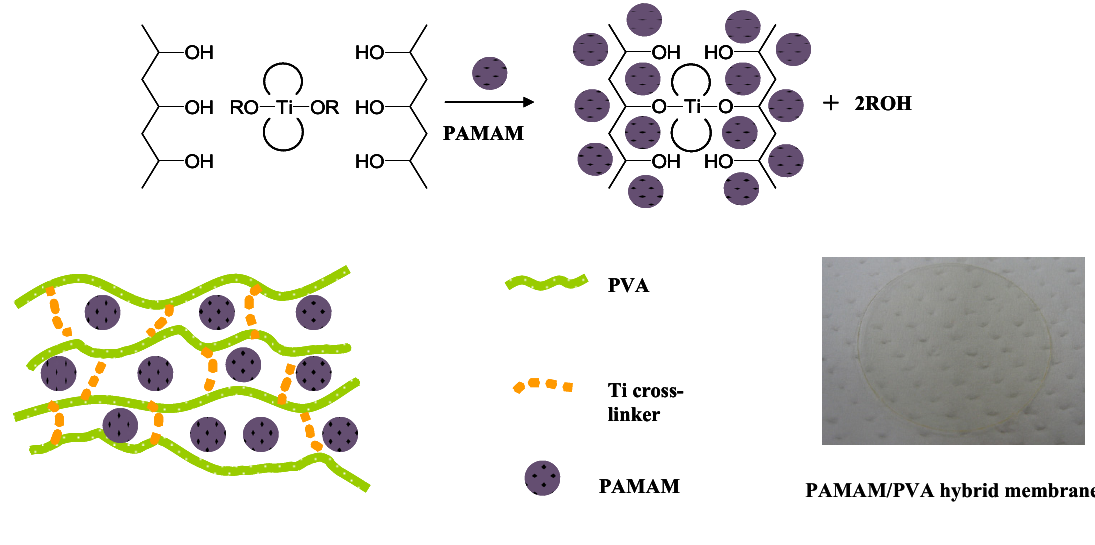
Figure 2. Schematic diagram of a PAMAM-immobilized Ti cross-linked PVA